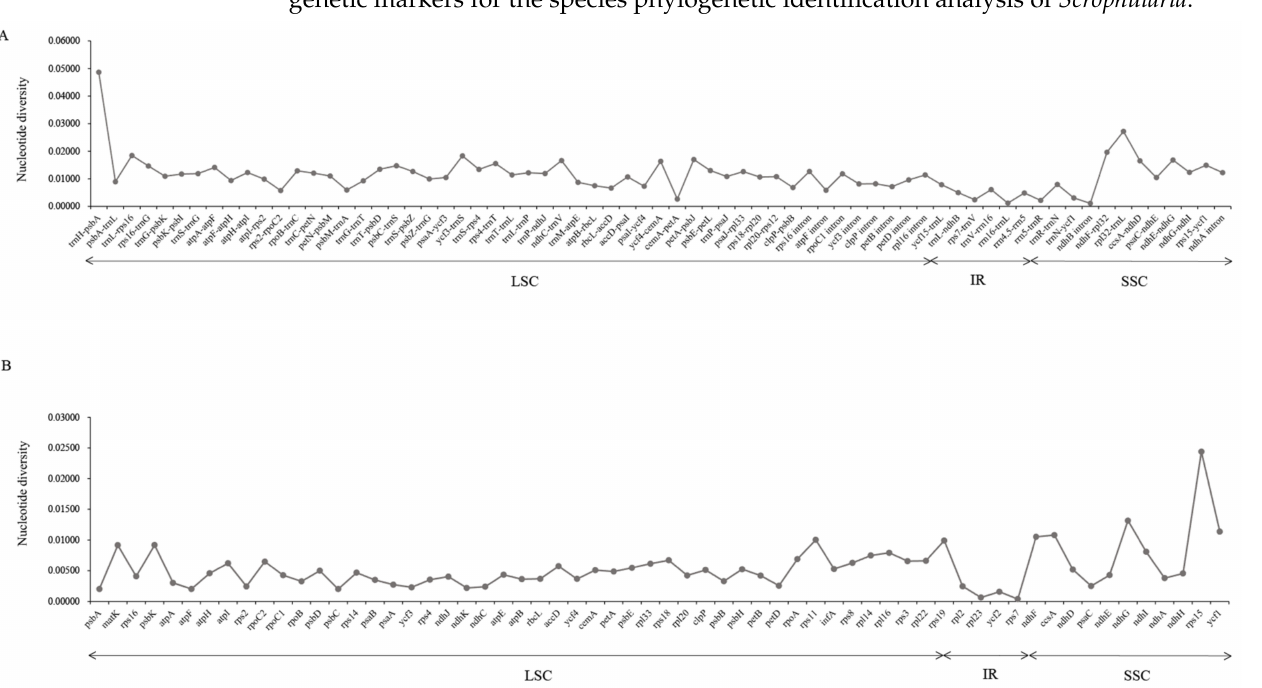
Figure 5. Comparison of nucleotide variability ( Pi ) values in Scrophularia plastomes. ( A ) Pi values among intergenic spacer (IGS) and intron regions. ( B ) Pi values among protein-coding genes